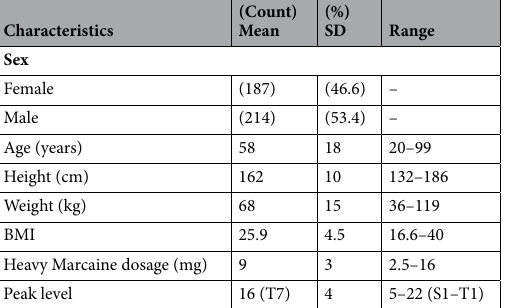
Table 1. Patient demographics. SD, standard deviation; BMI, body mass index.